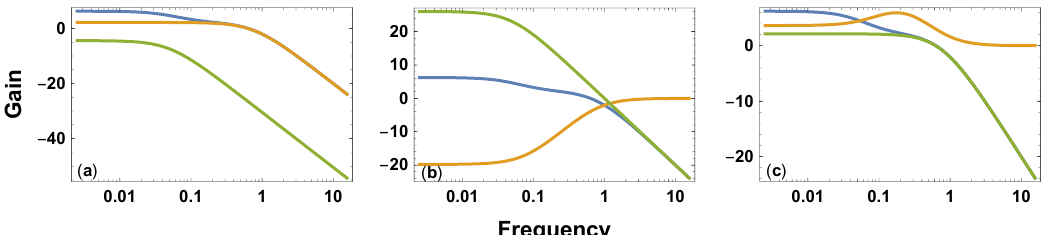
Figure 3. Frequency response of alternative models that yield identical biexponential decay. Each curve shows the relation between the frequency of input and the gain, which is the amount by which a process multiplies an input signal. The parameters match the red curve of Figure 1. The blue curve is the response of the total system, G , which is the same in all cases. The gain expresses the classic ( gain ) . A value of zero corresponds to gain of one, which means signal processing scale of 20log 10 that the process passes the signal without change. Values of less than zero reduce the signal intensity, and values above zero enhance the signal intensity. ( a ) The combination of two low pass filters in Candia et al.’s model of Figure 2b. A similar pattern describes the additive parallel model in Figure 2c. ( b ) The combination of high and low pass pass filters in series in Figure 2d. ( c ) A low pass filter in green combined in a self-correcting feedback loop with a filter that enhances intermediate resonant frequencies in